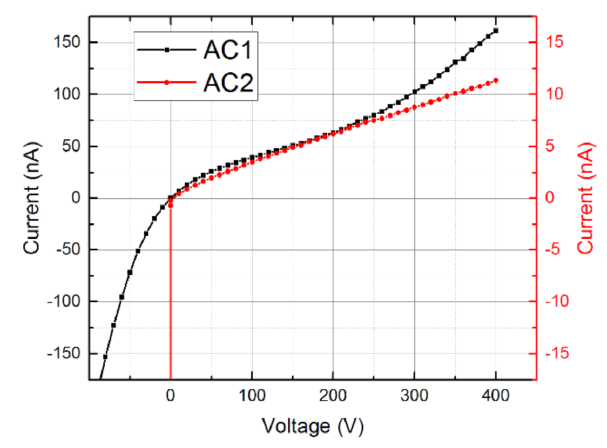
Figure 3. I-V curves of the used samples.